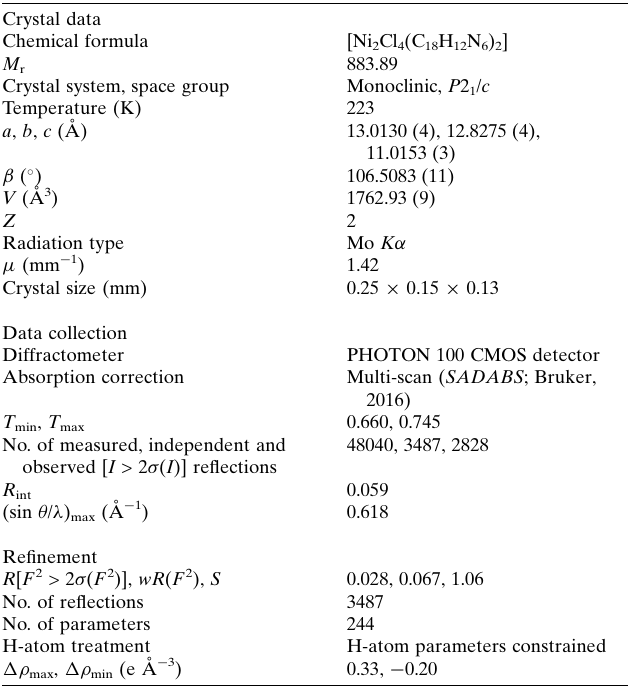
Table 2 Experimental details.